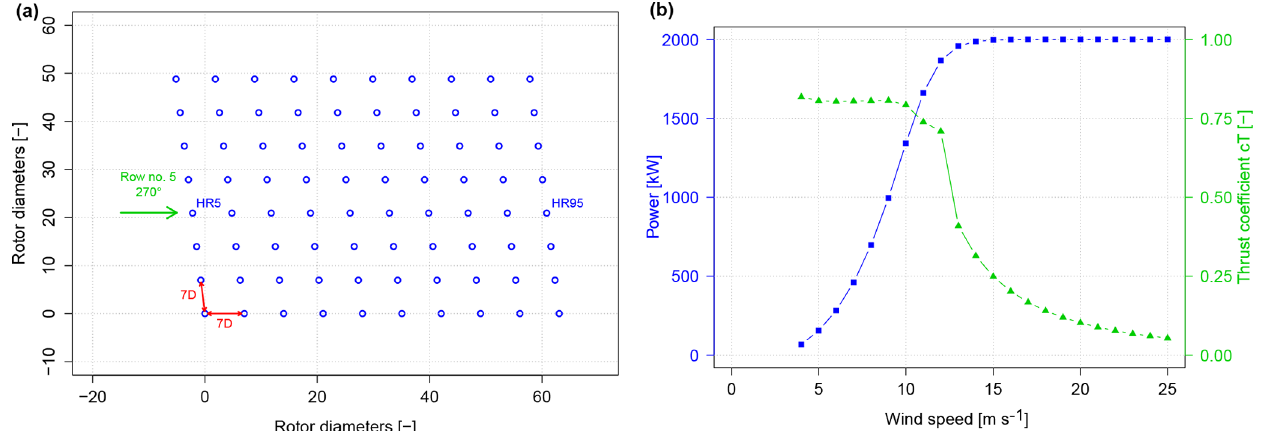
Figure 5. Layout of Horns Rev-I offshore wind farm with turbine spacing and wind direction angle used in this study (a) and Vestas V80-2MW guaranteed power and thrust coefficient ( c T ) curves (b)